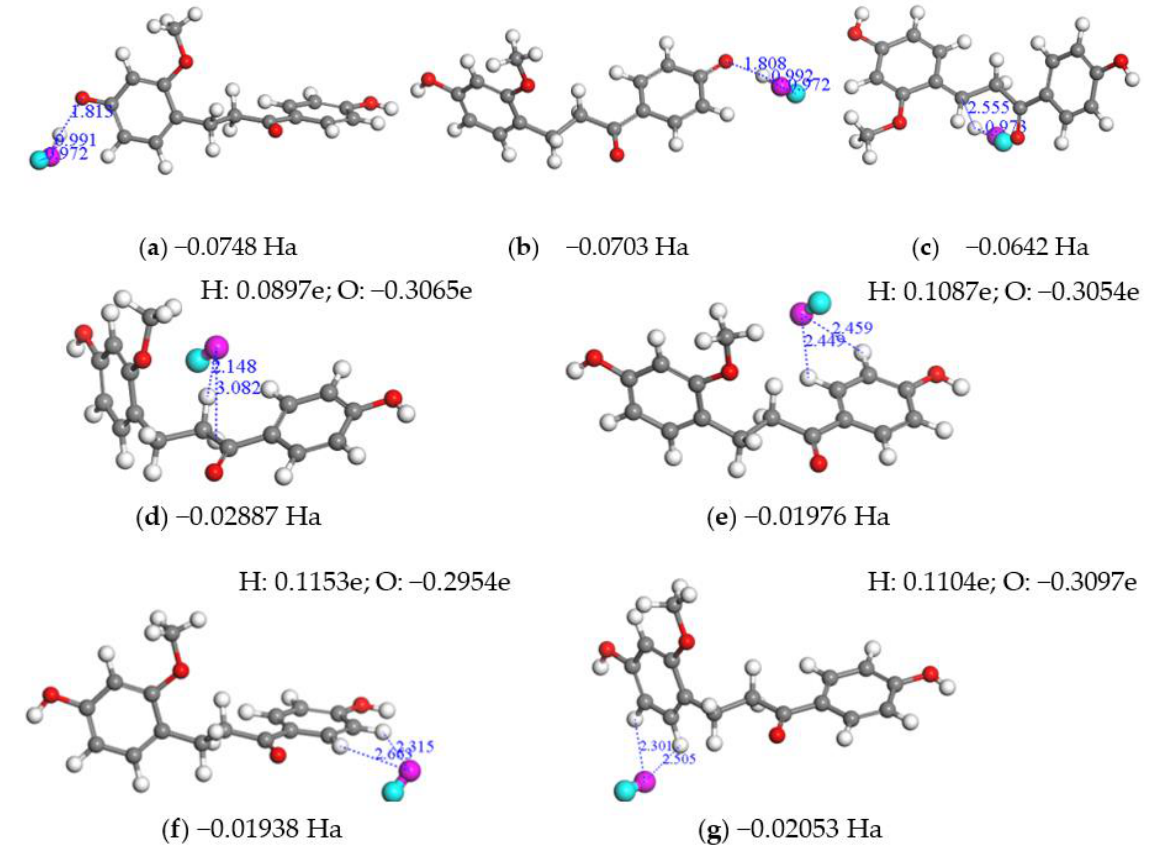
Figure 5. Optimized structures of LC+OH • radical in gas phase; ( a ) near to the OH of A ring (left) of LC; ( b ) near to the OH of B ring(light) of LC; ( c ) near to H21; ( d ) near to H23 and H24; ( e ) near to H28 and H30; ( f ) near to H29 and H31; and ( g ) near to H25 and H27. The energy difference between